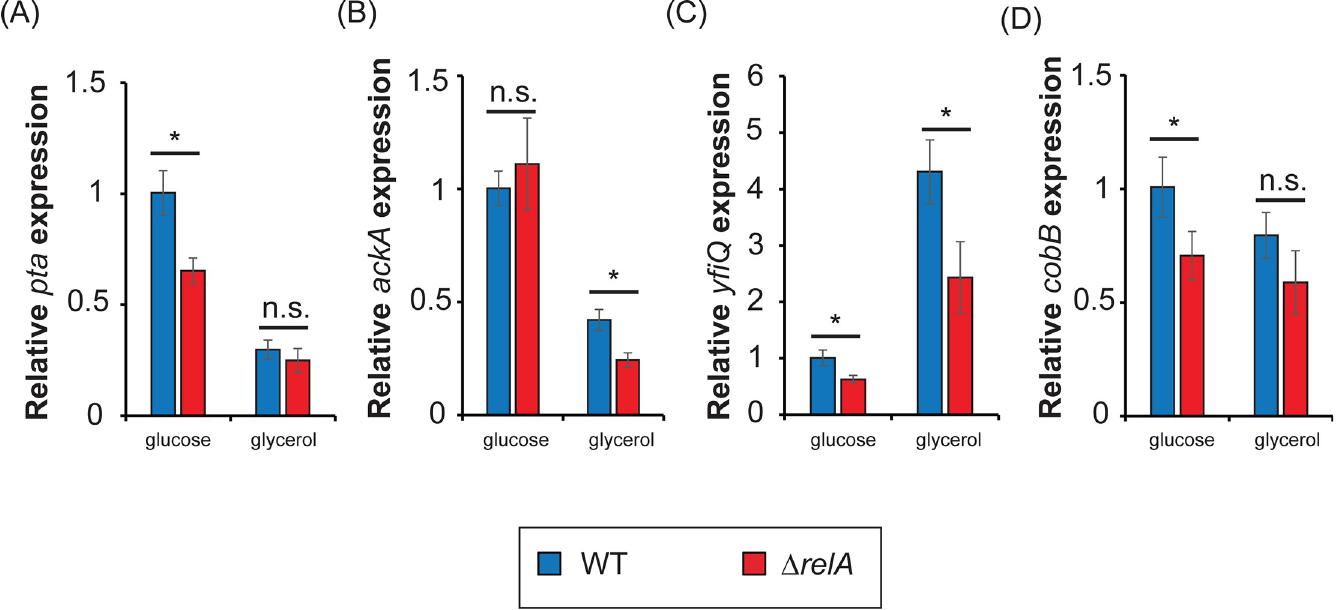
Fig 3. Effect of ppGpp on gene expression of the main factors contributing to protein acetylation. The gene expression of (A) pta , (B) ackA , (C) yfiQ and (D) cobB were measured by qPCR from WT and Δ relA cells grown in minimal media with glucose or glycerol. Expression levels are normalized to the expression in WT grown in glucose. Error bars show standard deviations of 2 biological samples and 3 technical replicates. Statistical significance was measured with T-student test ( � p-value < 0.05, n.s. p-value > 0.05).